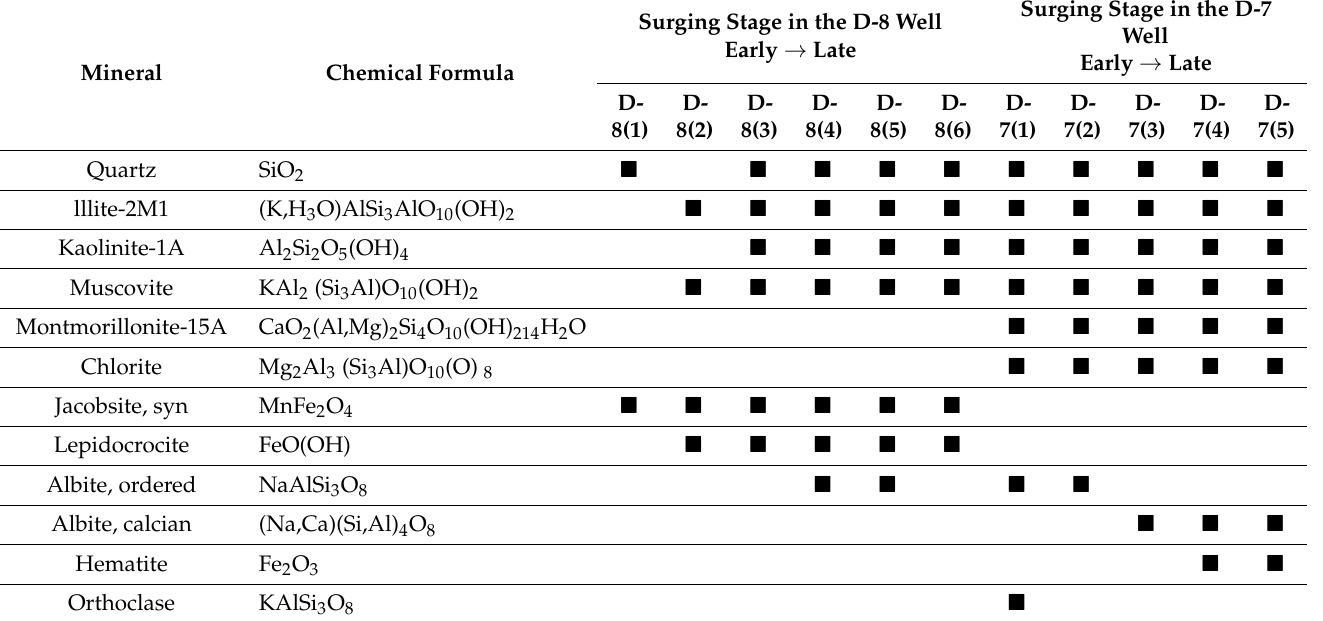
Table 5. XRD analysis results of the substances mixed with the overflowing water during the air surging